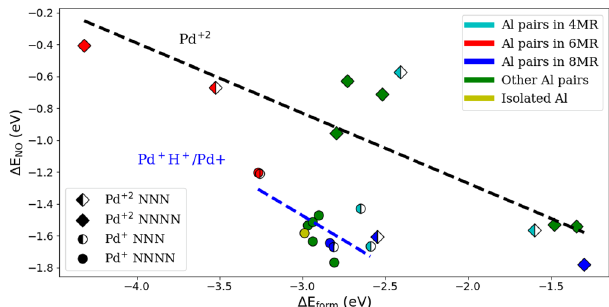
Fig. 9 Binding energy of a number of gaseous species on Pd-exchanged CHA (Pd + /Pd + H + ) against Pd formation energy (at unique Al con fi gurations). Dotted lines refer to fi tted data for each gas